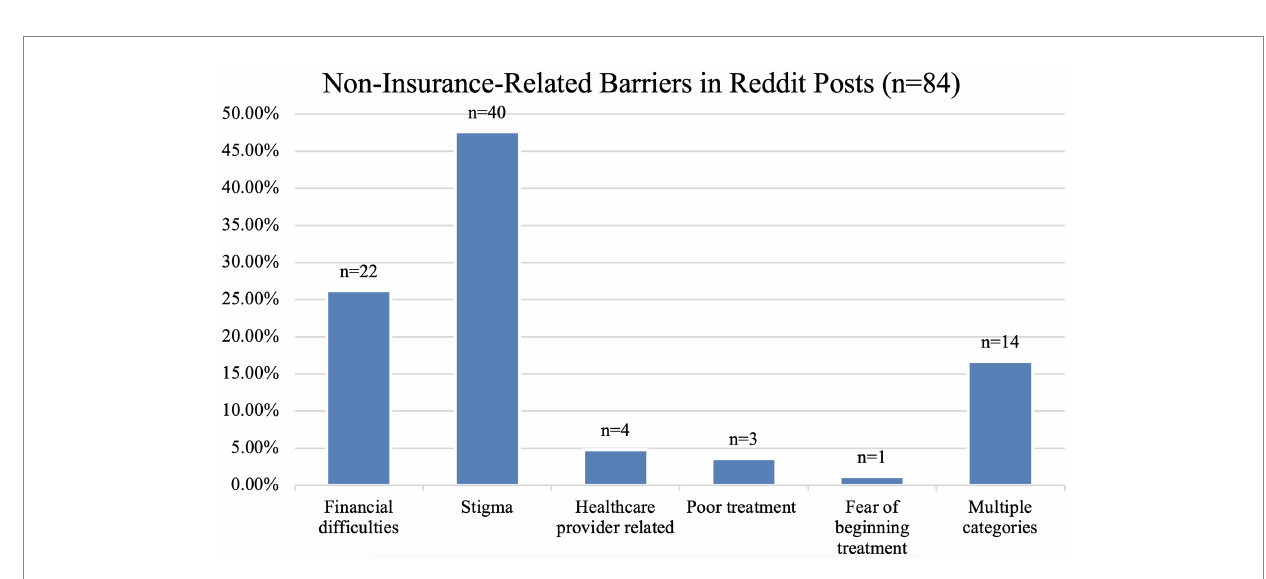
FIGURE 2 Breakdown of Non-Insurance Related Barriers found in Reddit